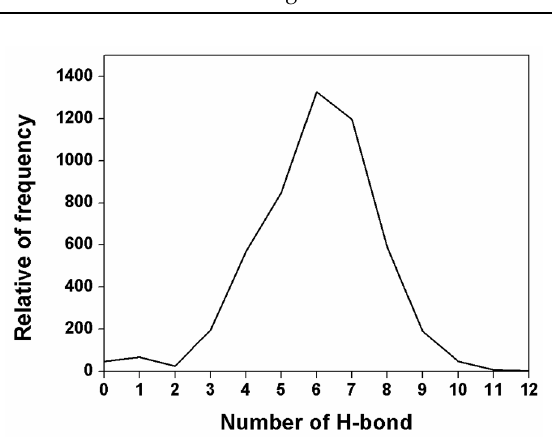
Figure 5. Distribution of hydrogen bond numbers between NanA and chlorogenic acid.